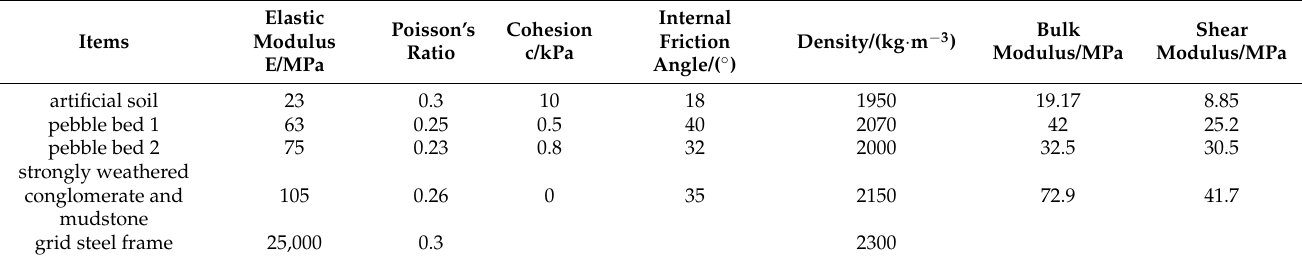
Table 1. Parameters of the soil mass and primary lining.